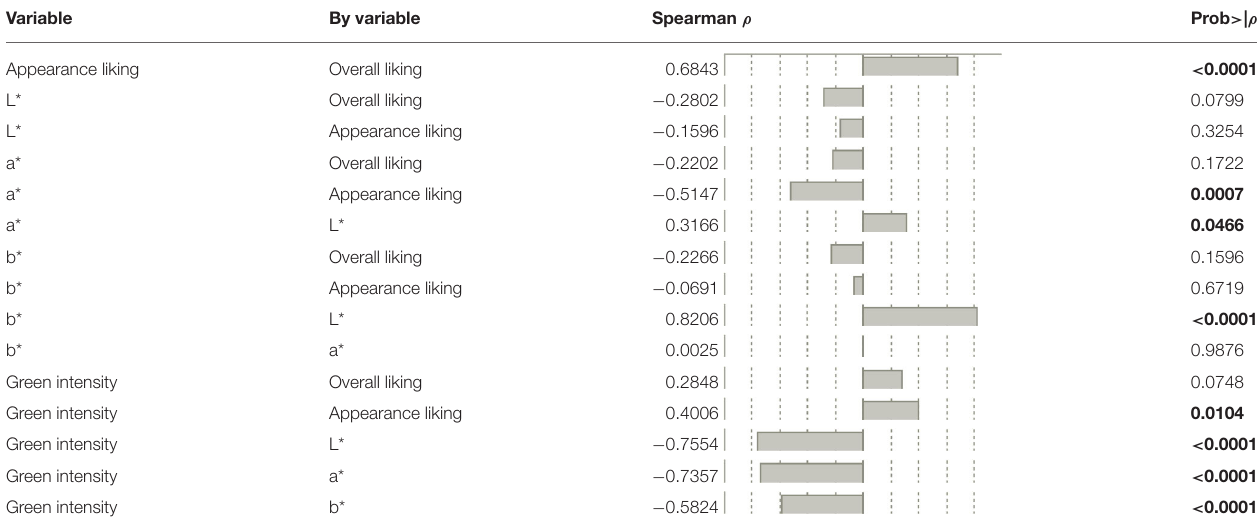
TABLE 3 | Correlation between color characteristics and consumer acceptability (appearance and overall liking) of edamame.